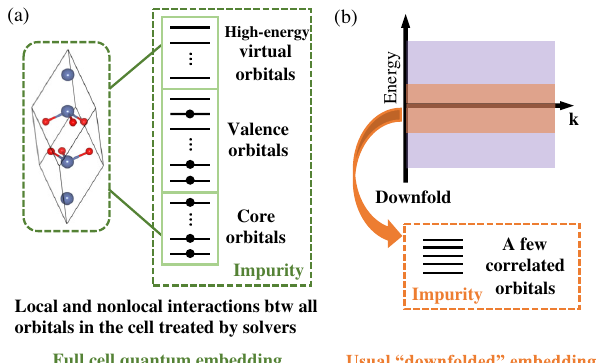
FIG. 1. Illustration of (a) ab initio full cell GW þ DMFT and (b) usual GW þ DMFT schemes. In full cell embedding, all orbitals in the full unit cell (four Fe and six O atoms) are taken as the impurity in the α -Fe 2 O 3 calculation. In contrast, other GW þ DMFT formulations define the impurity problem to contain a few correlated orbitals within a low-energy subspace which interact via downfolded, retarded,